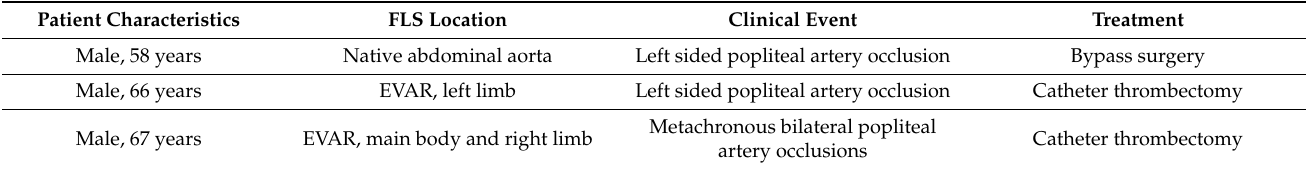
Table 1. Clinical characteristics and treatment of symptomatic